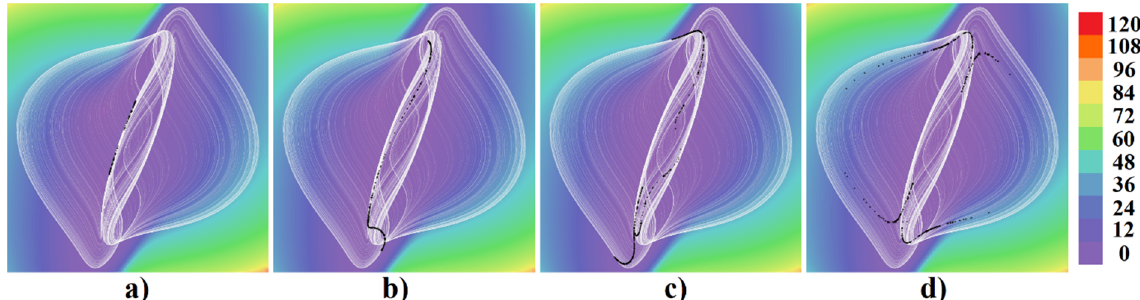
Figure 7. Distribution of kinetic energy normalized to final time 1 s over the state space for chaotic attractor generated by the first case of third order system. Poincaré sections (black dots) are taken as the intersections of a state trajectory (white curve) with horizontal planes defined by: ( a ) z = −3.3, ( b ) z = −2, ( c ) z = −1, ( d ) z = 0.